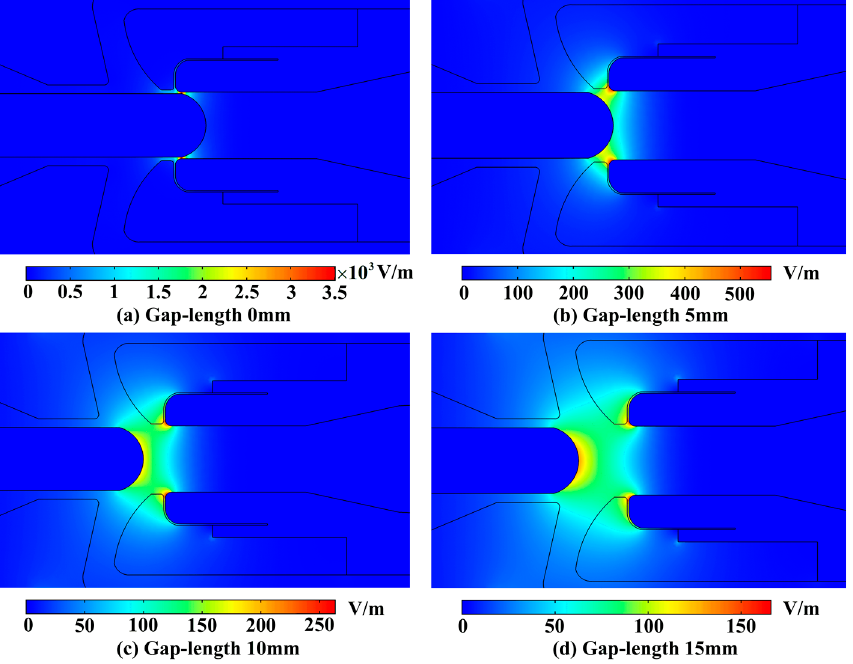
Figure 5. Electric field distribution of arc extinguishing chamber.